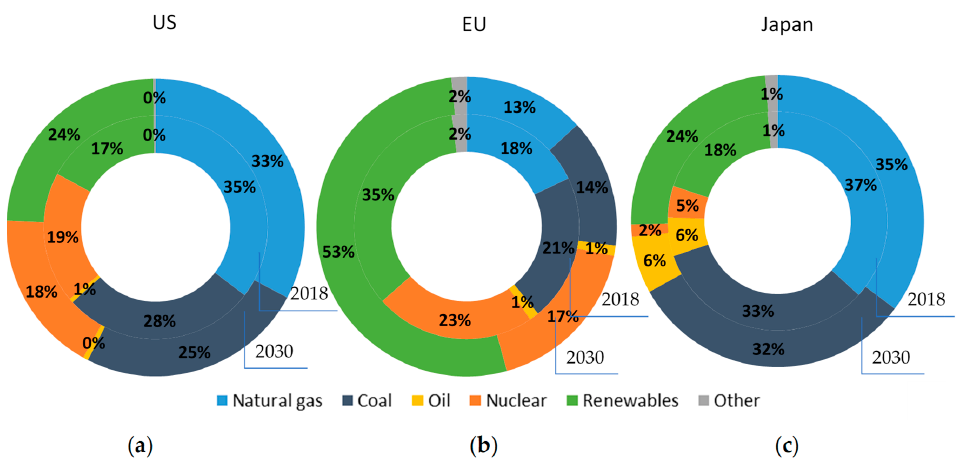
Figure 4. Share of particular energy sources in electricity generation 2018 with a scenario for 2030 in: ( a ) the United States; ( b ) European Union; ( c ) Japan.